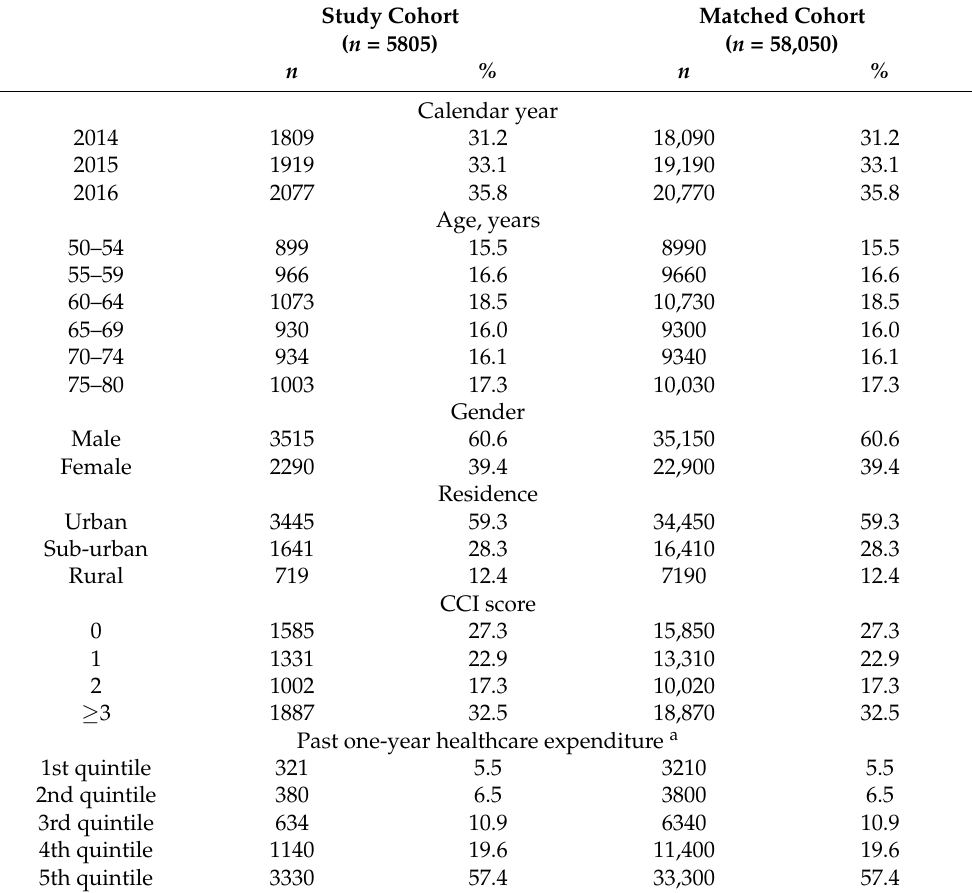
Table 2. Characteristics of the study and 1:10 matched